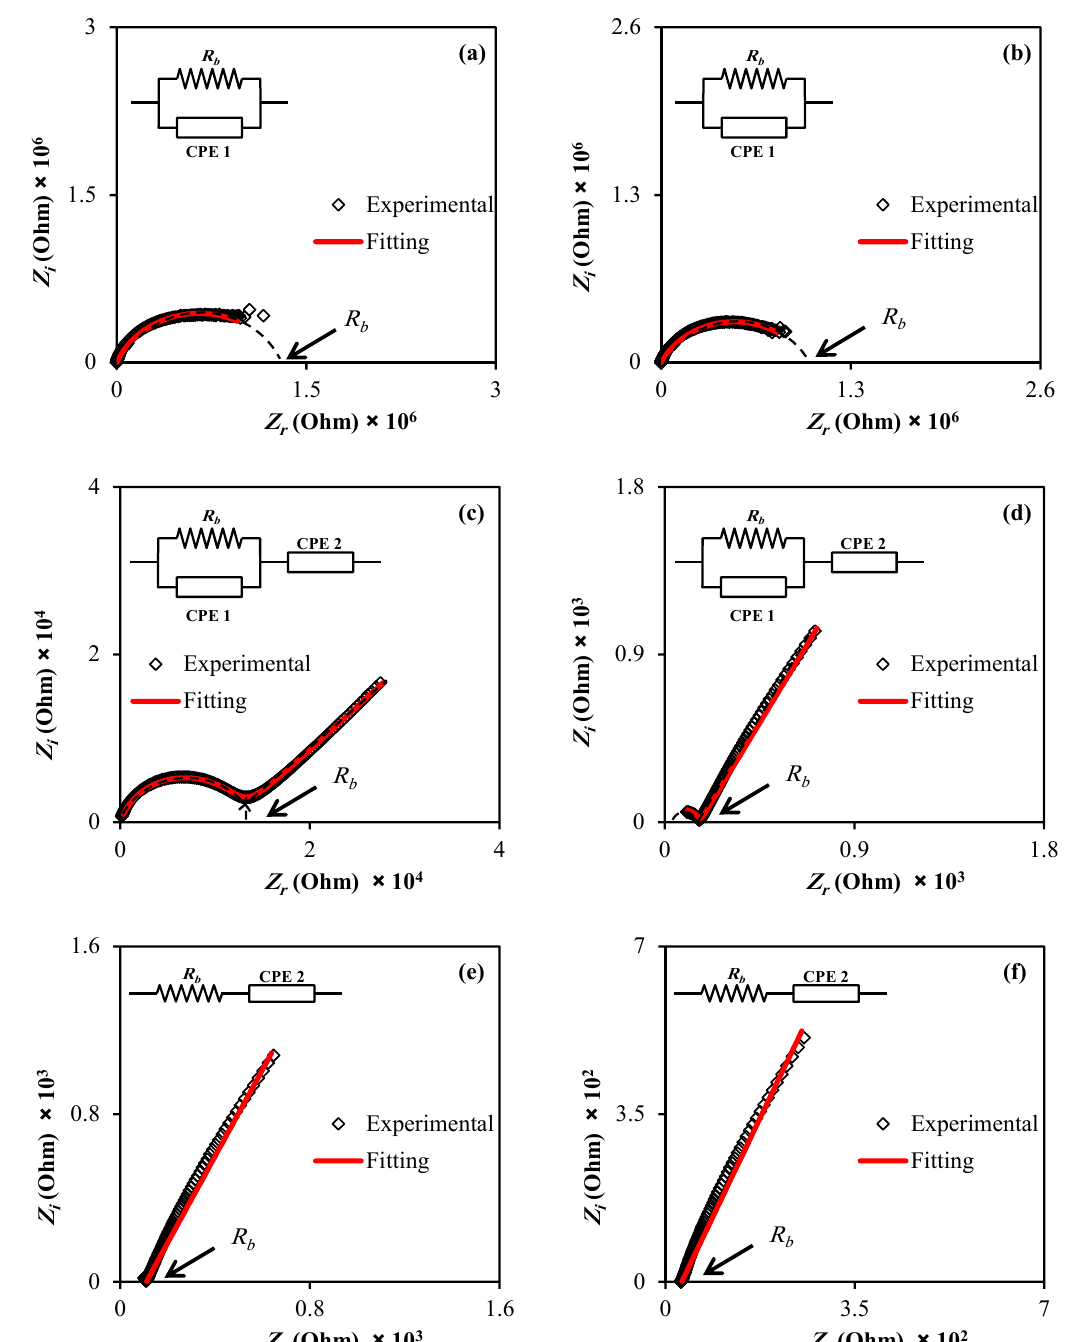
Figure 4. Impedance plots of the ( a ) MC:KI film, ( b ) MCPN1, ( c ) MCPN2, ( d ) MCPN3, ( e ) MCPN4, and ( f ) MCPN5.